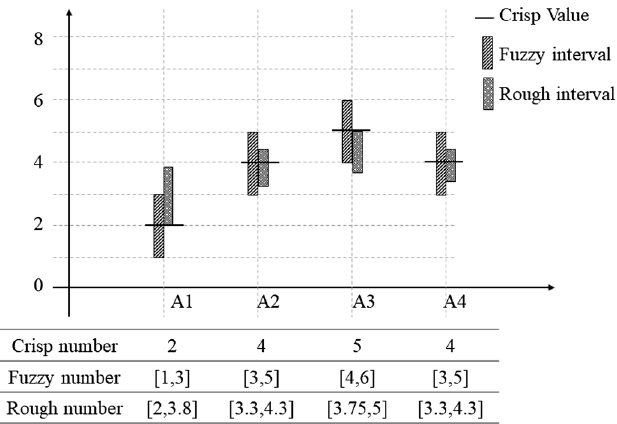
Figure 1. Comparison of crisp number, fuzzy number and rough number